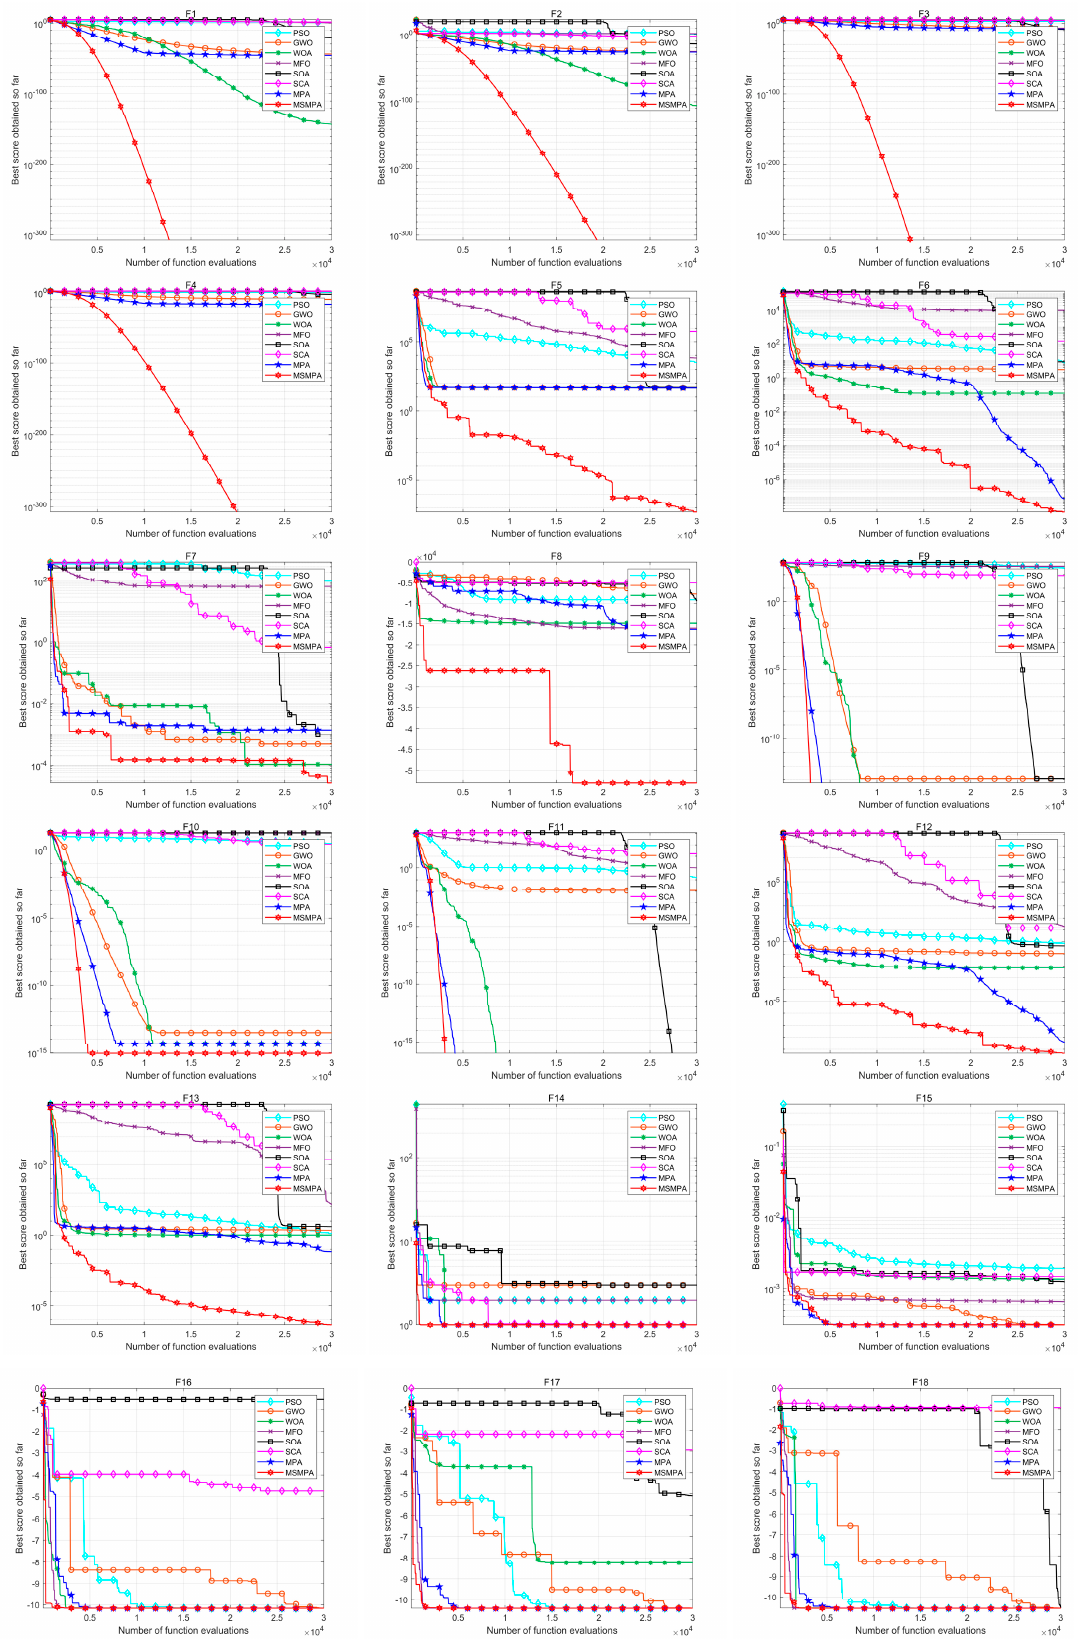
Figure A1. Convergence curves for 18 benchmark